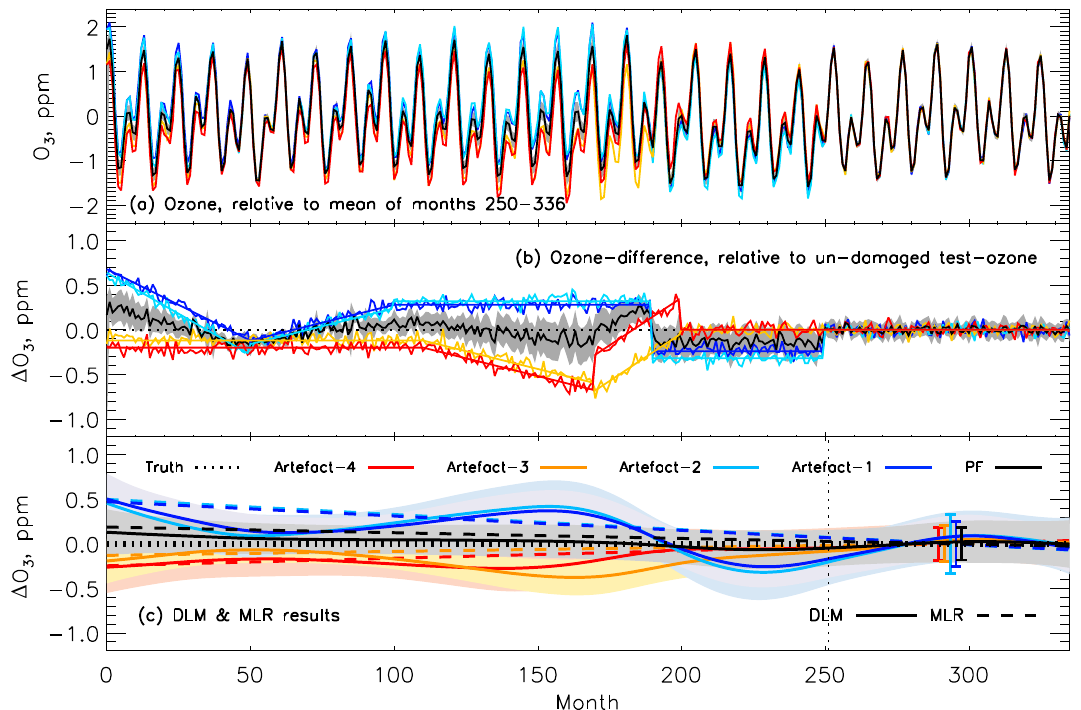
Figure A9. A test case to evaluate the performance of the BASIC approach. Damaged time series are plotted in panel (a) relative to the mean of months after 250 in light blue, blue, yellow, and red, and the BASIC result in black. Differences of time series in panel (a) relative to the undamaged (test) time series is shown in panel (b) ; the straight coloured lines in panel (b) represent the artefacts applied to the undamaged time series to produce the damaged ones in panel (a) ; grey and shading in panels (a) and (b) represent the 95% credible intervals of the BASIC result. In panel (c) , we show the estimated trends over the full period from multiple linear regression (MLR; dashed) and the dynamical linear model in solid lines. The true trend during this period is zero (dotted